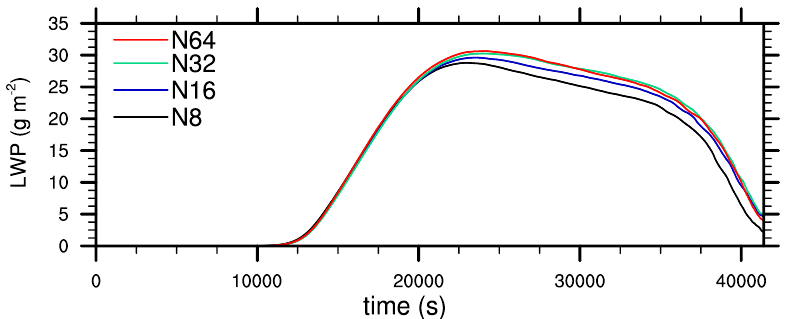
Figure A1. Time series of liquid water path for the sensitivity studies with different superdroplet